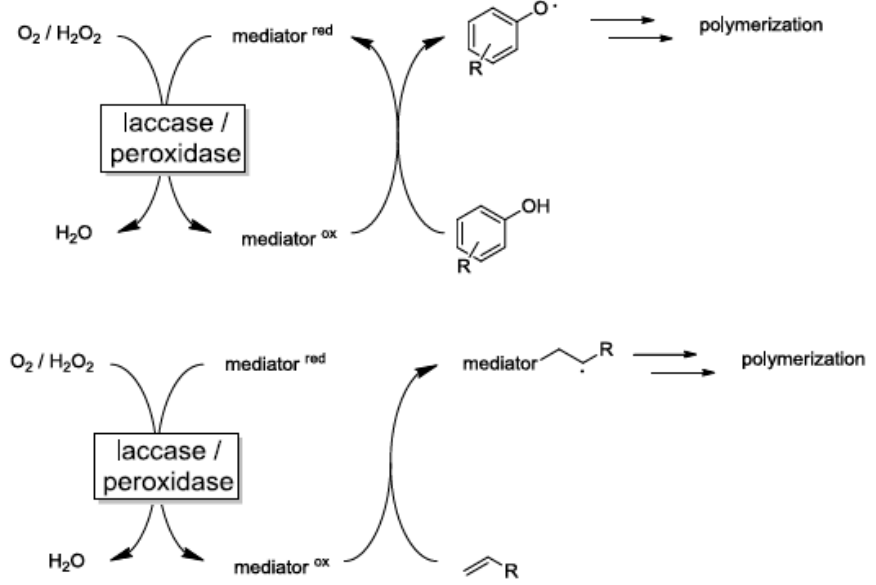
Figure 5. Illustration of laccase and peroxidase mediator systems (PMSs) in polymerization reac- tions [76].